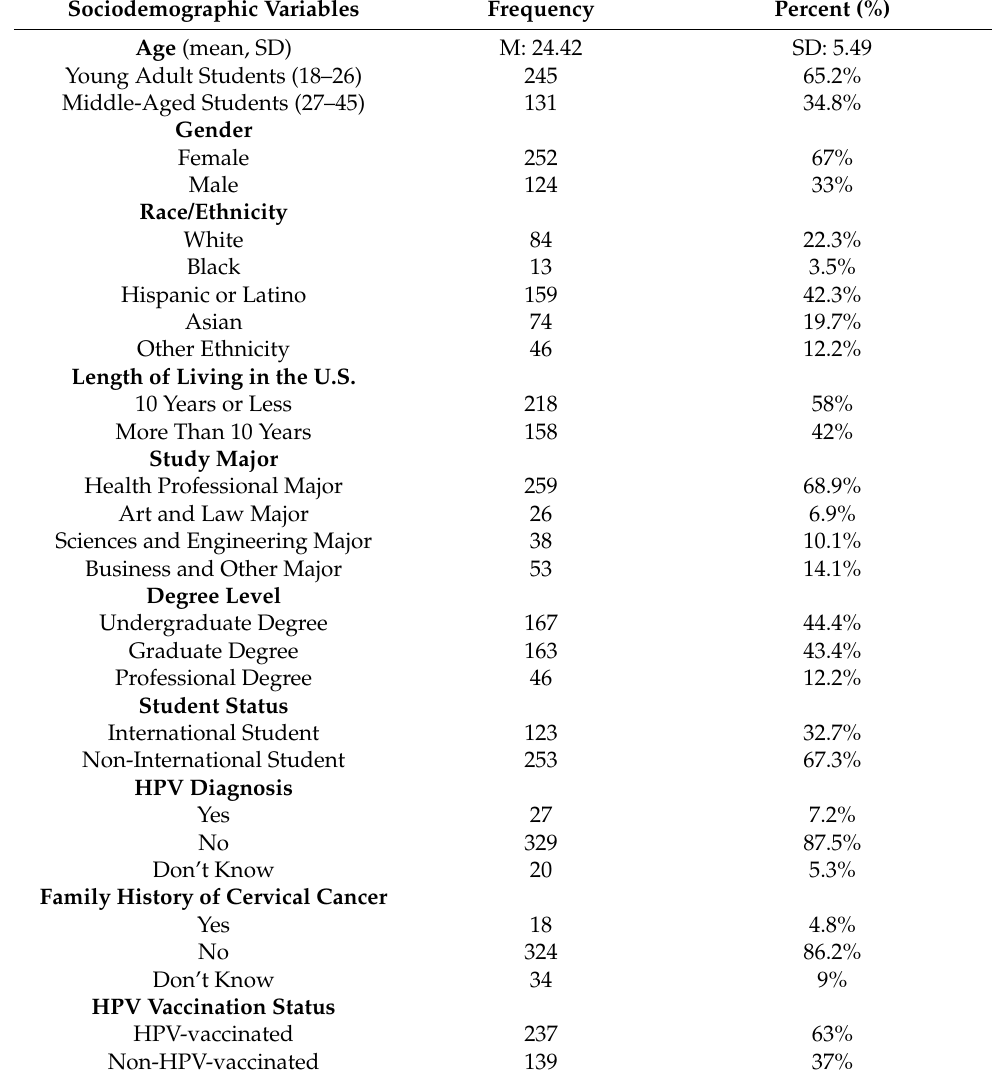
Table 1. Sociodemographic characteristics of foreign-born college